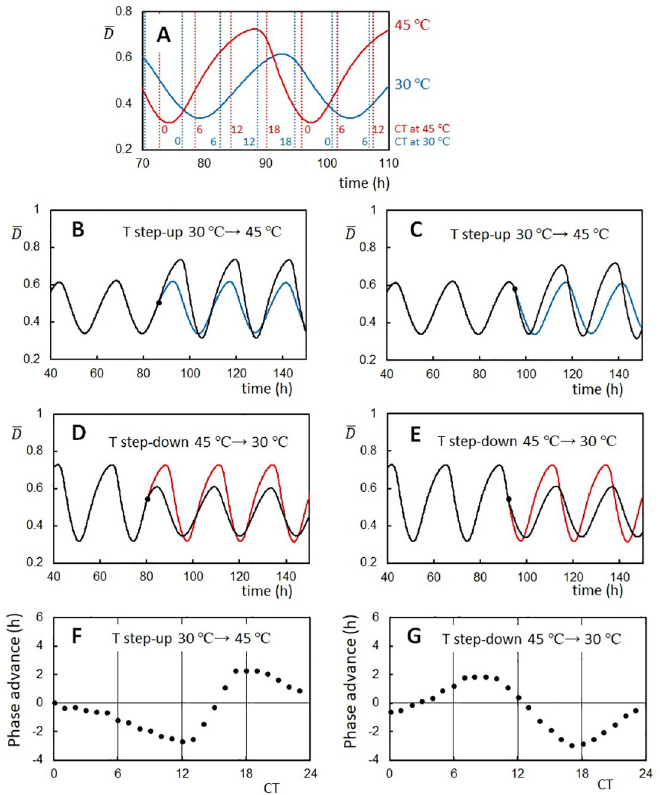
Fig 6. Phase shifts of the ensemble-averaged oscillations of the KaiC phosphorylation level caused by temperature steps. ( A ) Circadian Time (CT) was set to be 16 at the peak of oscillations at each temperature and the period was normalized to be 24 h in CT. Time denoted on the x -axis is the simulated incubation time (IT). ( B ) An example trajectory showing the phase delay upon temperature step-up from T = 30˚C to T = 45˚C at CT 9 (filled circle at IT 85.6 h). ( C ) An example trajectory showing the phase advance upon temperature step-up from T = 30˚C to T = 45˚C at CT 17.3 (filled circle at IT 95). In B and C , The oscillation trajectory going through the temperature step-up (black) and the trajectory with the constant temperature at T = 30˚C (blue) are superposed. ( D ) An example trajectory showing the phase advance upon temperature step-down from T = 45˚C to T = 30˚C at CT 7.9 (filled circle at IT 80.4). ( E ) An example trajectory showing the phase delay upon temperature step-down from T = 45˚C to T = 30˚C at CT 20 (filled circle at IT 92). In D and E , The oscillation trajectory going through the temperature step-down (black) and the trajectory with the constant temperature at T = 45˚C (red) are superposed. ( F ) Phase response curve (PRC) plotted as a function of CT when the temperature was stepped up from T = 30˚C to T = 45˚C. ( G ) PRC plotted as a function of CT when the temperature was stepped down from T = 45˚C to T = 30˚C. Rule 1, Rule 2, and Rule 3 in Table 1 were used with Δ E 0 = 6 k B T 0 and N =